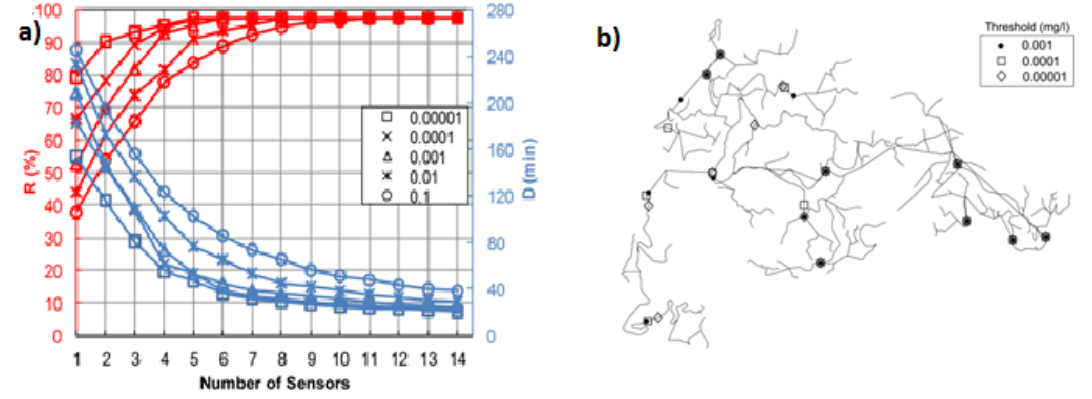
Figure 5. Procedure GR4 for different detection thresholds: ( a ) D and R values as a function of the number of sensors; ( b ) sensor placement.